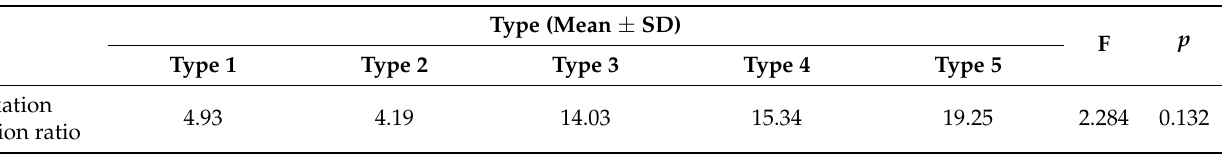
Table 27. Homogeneity of variance analysis for the proportion of fixation time on button of different